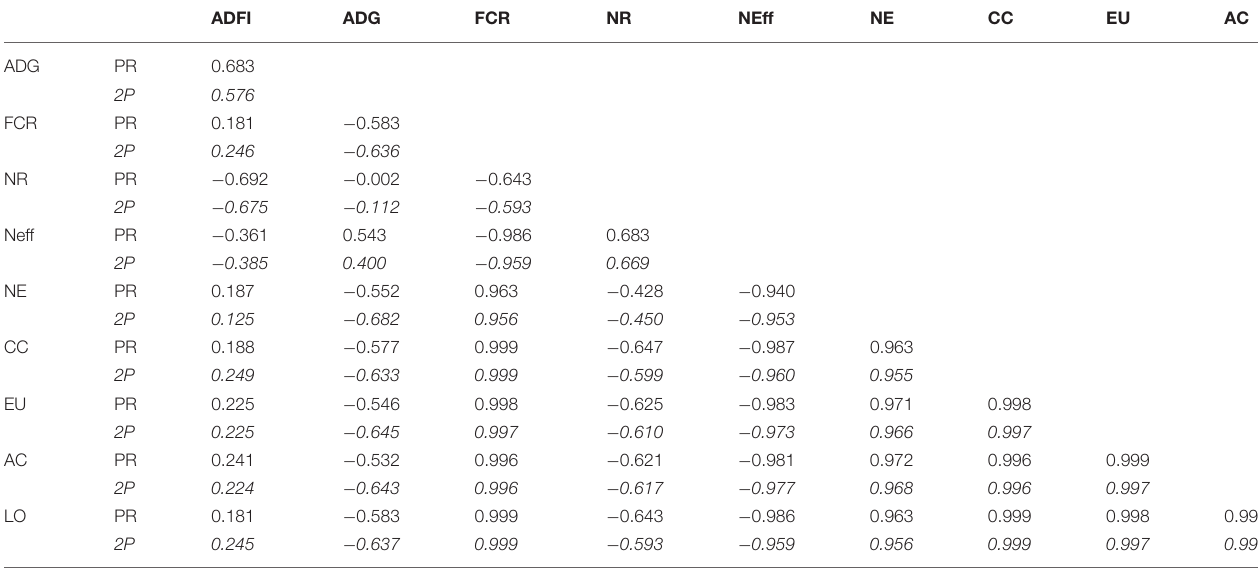
TABLE 2 | Correlations a between performance traits, nitrogen excretion, and environmental impacts, for the precision (PR) and the two-phase (2P, in italic) feeding strategies. ADFI